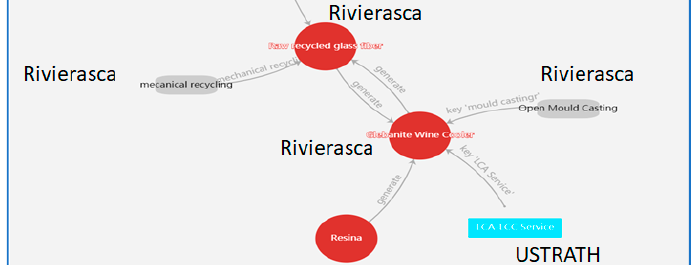
Figure 7. Value Chain Eco-System chart extract (circular entities: red, processes: gray, services: light blue)